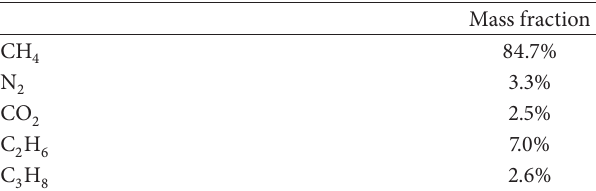
Table 5: Natural gas fuel composition. Table 6: Assumptions used in cycle